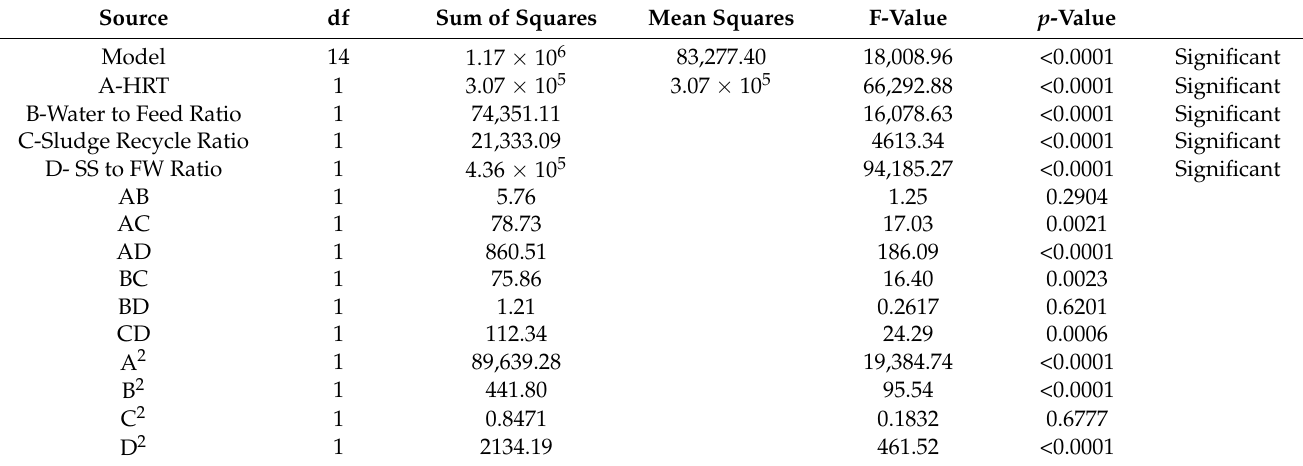
Table 4. ANOVA analysis for methane flow